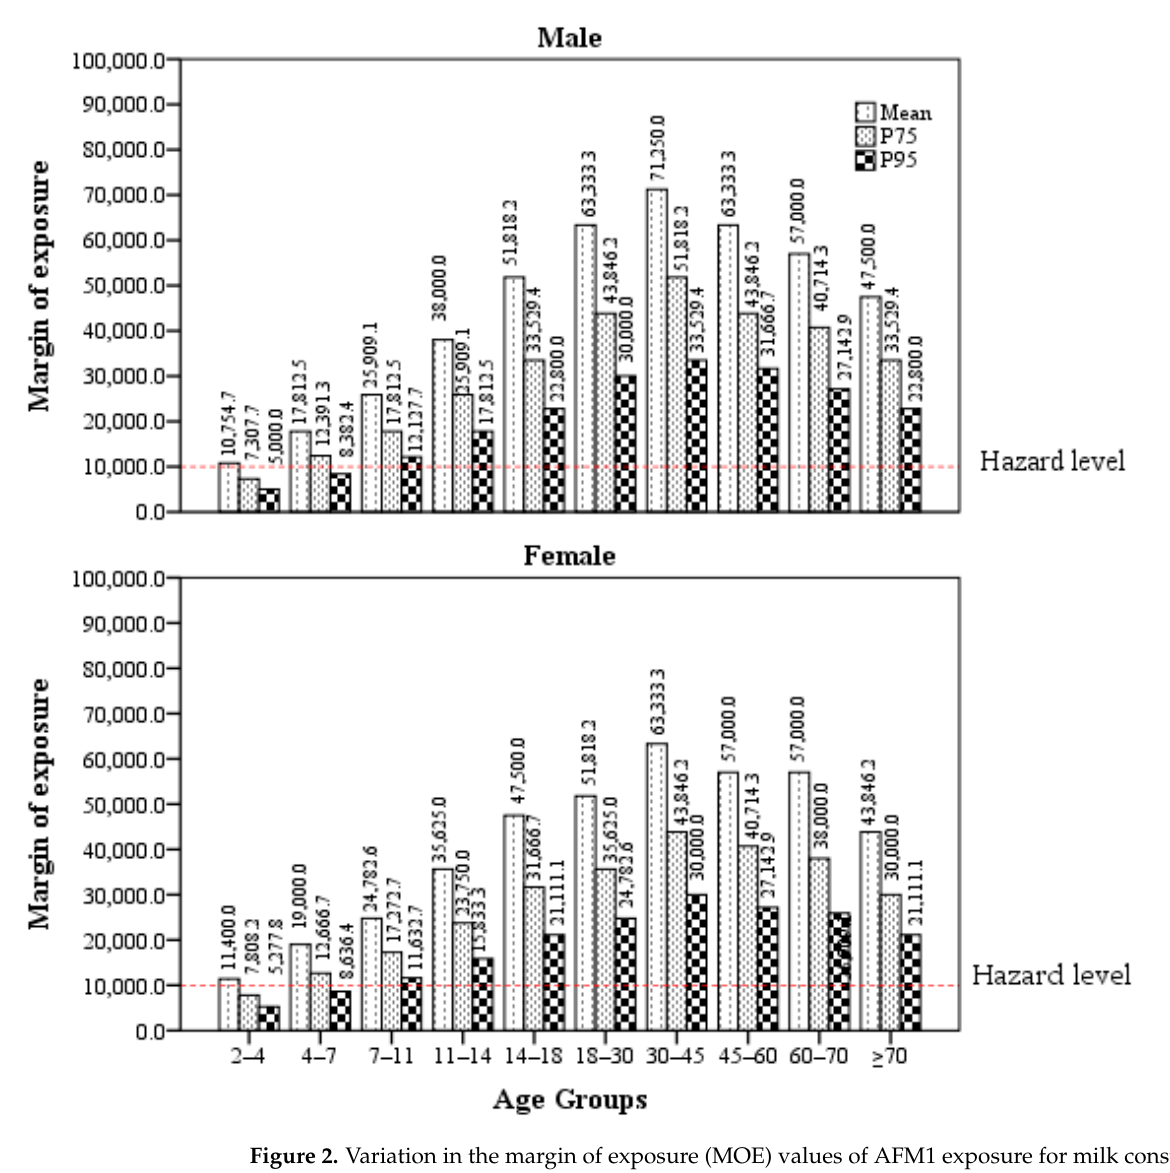
Figure 2. Variation in the margin of exposure (MOE) values of AFM1 exposure for milk consumers in different age-sex groups. The means of the MOEs for each age group were lower than 10,000, indicating that milk consumers were at low health risk overall, while some MOEs, including the 75% and 95% percentiles of MOE values for children aged 2–4 years and the 95% percentile of MOE values for children aged 4–7 years, were below the 10,000, indicating that milk consumers were at health risk to some extent. Note: (1) To calculate estimated daily intake (EDI), the concentrations of AFM1-negative milk samples were assumed to be 2.5 ng/L (half of the detection limit of 5 ng/L), from which the mean, 75% percentile, and 95% percentile concentrations were calculated to be 4.78, 7.04, and 10.32 ng/L, respectively. These concentrations were then used to calculate the corresponding EDI values. (2) MOE = (570 ng/kg bw/day)/EDI, where the value of 570 ng/kg bw/day is the reference dose, based on the results of an AFM1 exposure test on Fischer rats [22]. (3) If the calculated MOE value is greater than or equal to 10,000, milk AFM1 poses little health risk, while if the MOE values is less than 10,000, it poses a potential health risk.